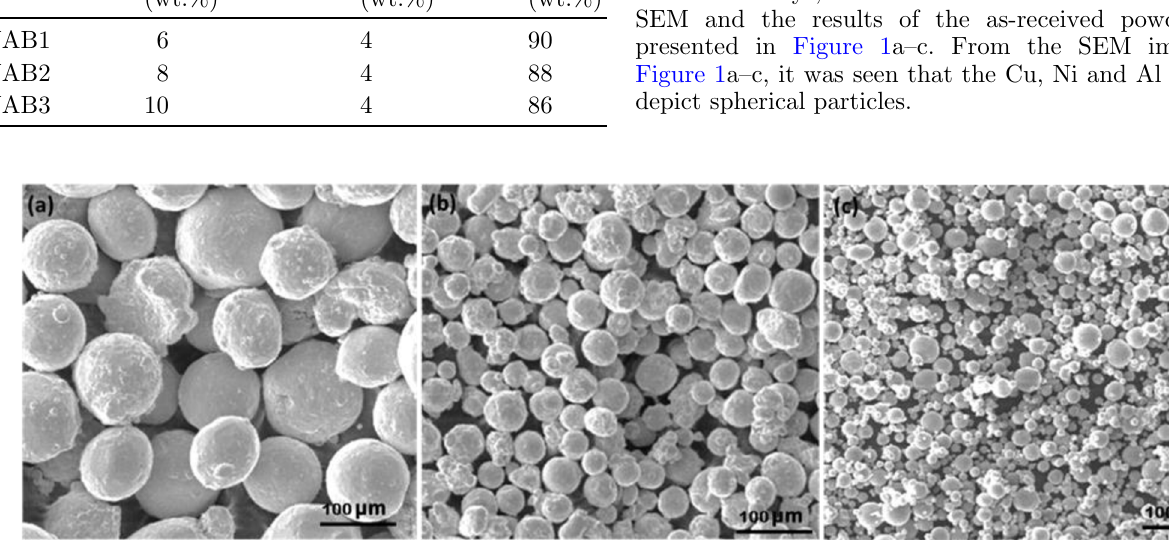
Fig. 1. SEM results of the as-received elemental powders (a) Copper, (b) Nickel and (c)